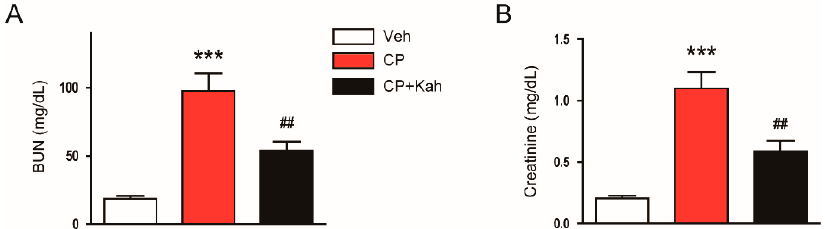
Figure 1. Effect of kahweol on plasma blood urea nitrogen (BUN) and creatinine levels in cisplatin-injected mice. Mice were given an intraperitoneal administration with kahweol (20 mg/kg; Kah) daily for 4 consecutive days, starting from 1 day prior to cisplatin injection. All mice were sacrificed 72 h after cisplatin injection and the blood was collected. ( A ) BUN levels. ( B ) Plasma creatinine levels. n = 8 per group. *** p < 0.001 vs. the vehicle-treated control group (Veh). ## p < 0.01 vs. the cisplatin-injected group (CP).